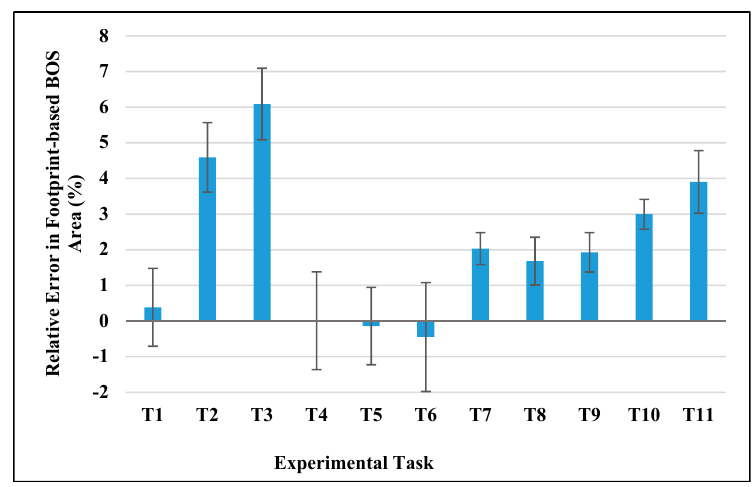
Figure 11. Errors of footprint-based BOS area in different experimental tasks when an optical camera system (OptiTrack V120: Trio) was used as a gold reference. Sensors 2017 , 17 , 2091